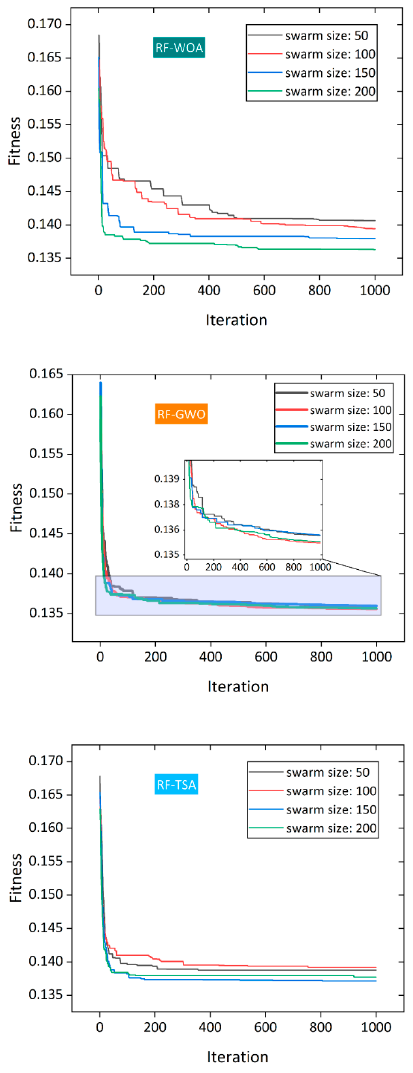
Figure 7. Various RF-based metaheuristic models based on different swarm sizes.